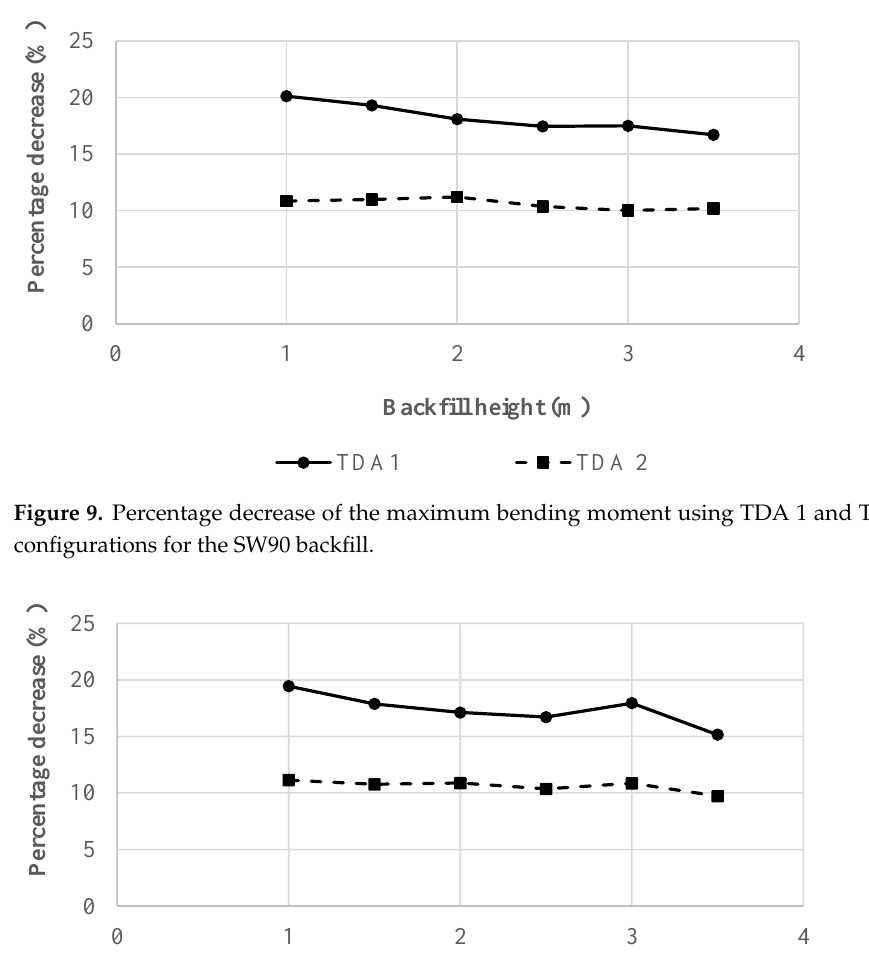
Figure 8. Effect of the backfill height on the maximum bending moment for the three trench config- urations considering the ML90 as a backfill soil.